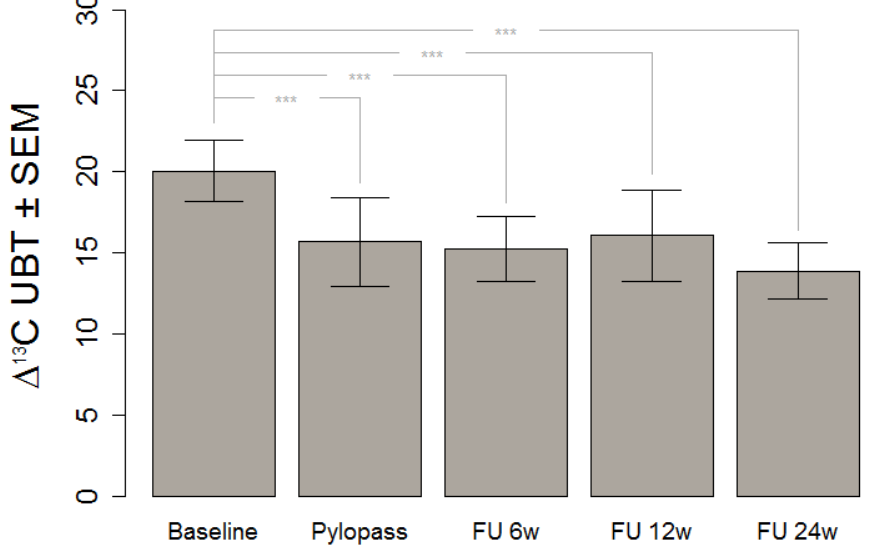
Figure 3. Absolute 13 C UBT values before and after supplementation with Pylopass™ as well during